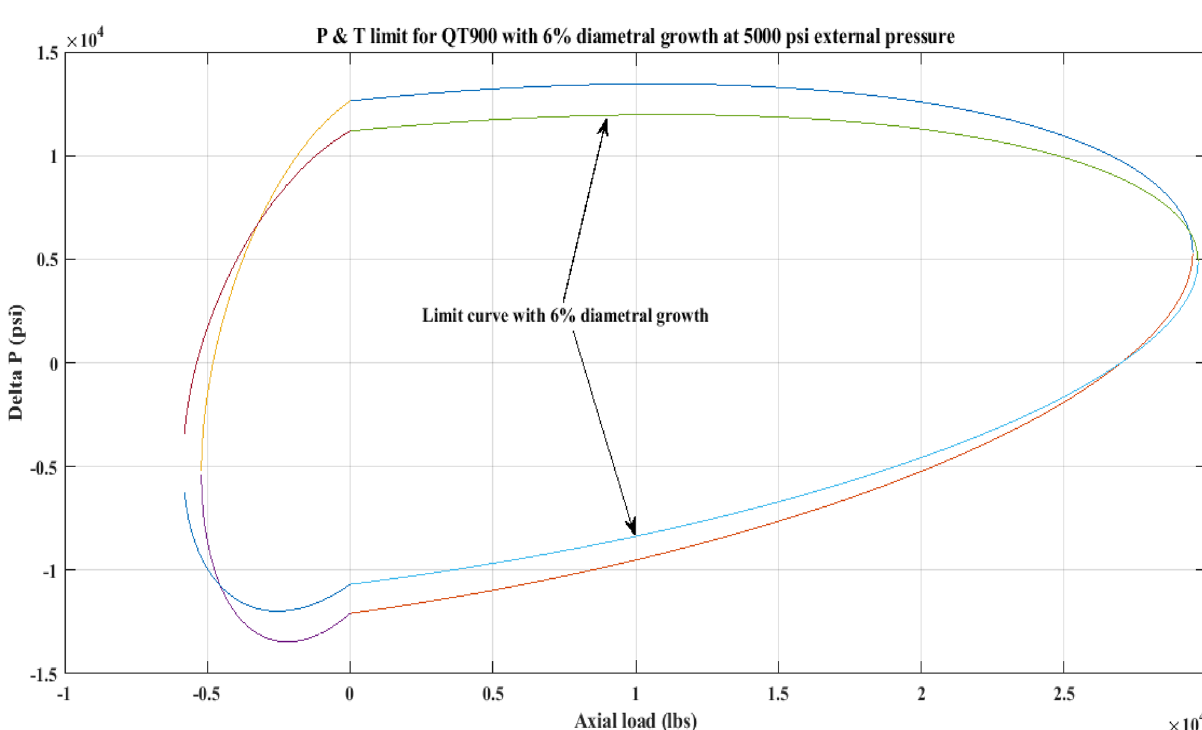
Figure 12. P and T limit with diameter growth for QT 900 at 5000 psi P o